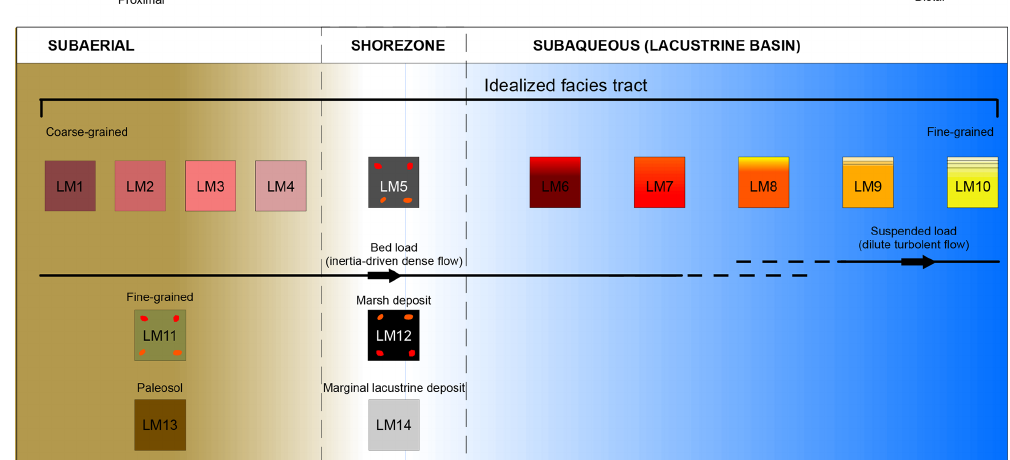
Figure 4. Idealized genetic facies tract showing the 14 lithofacies (LM1–LM14) identified within the reference core S1, whose stratigraphy is reported in Fig. 3.